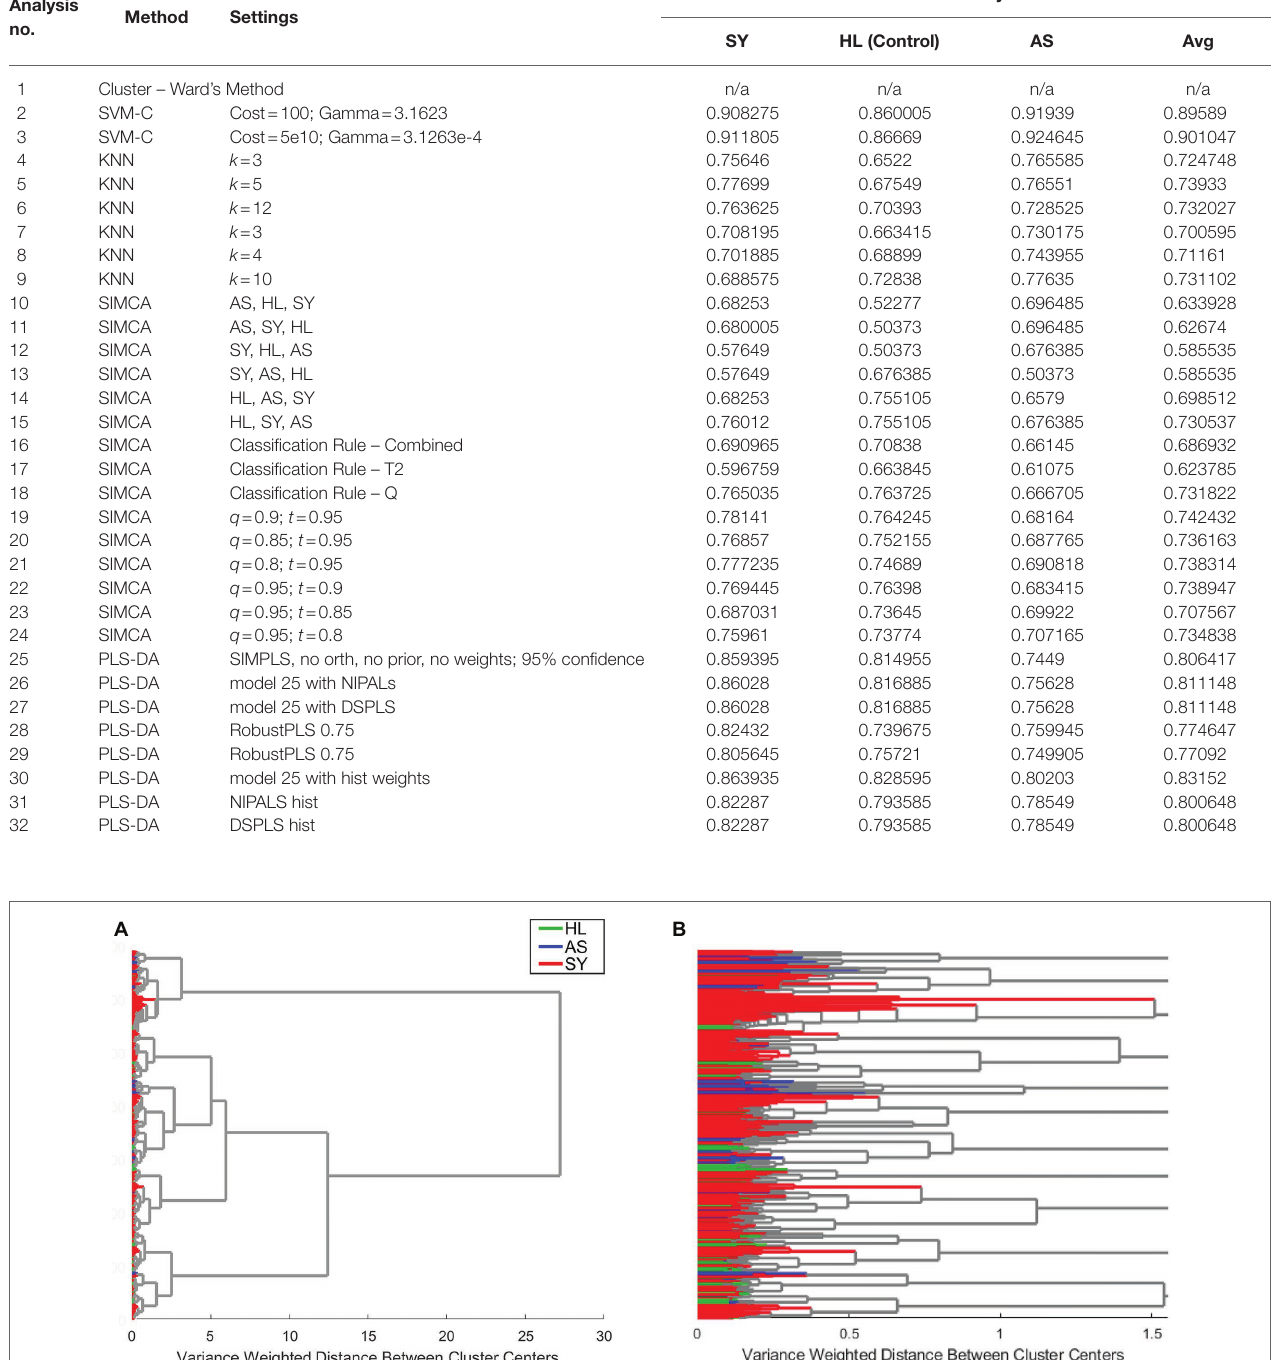
TABLE 3 | Performance of all classification models tested on the rose data. Analysis no.